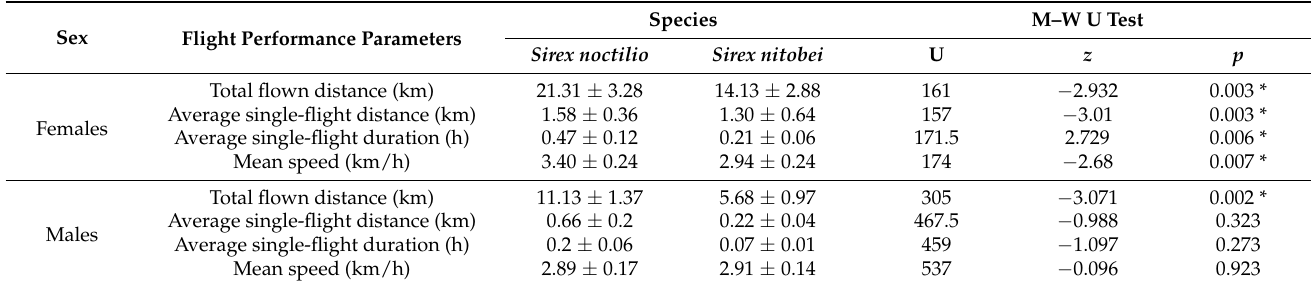
Data are presented as mean ± SE. Table A4. Comparison of flight performance parameters between Sirex noctilio and Sirex nitobei .